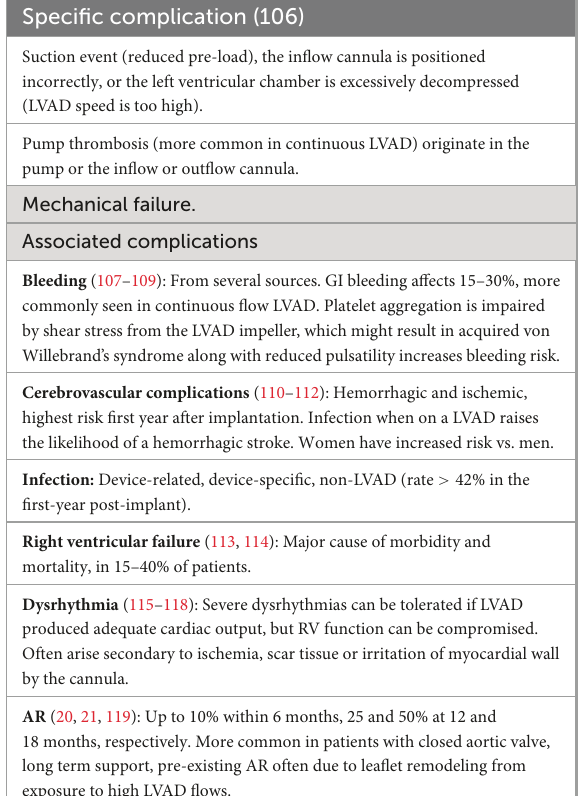
TABLE 1 Left ventricular assist device (LVAD) complications.